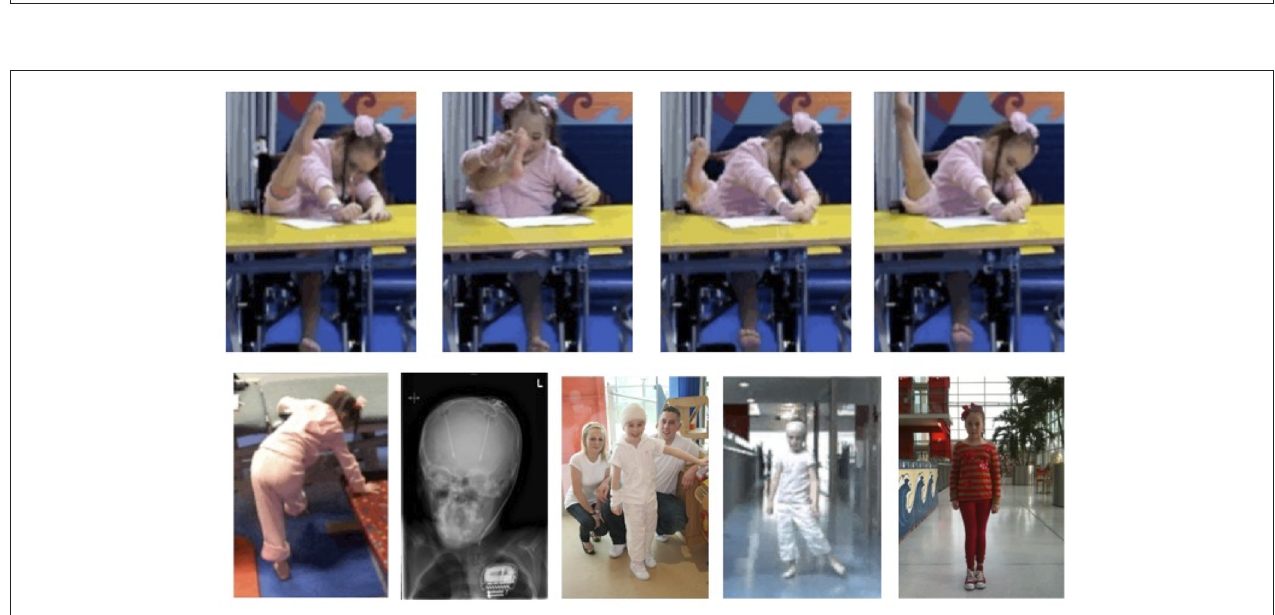
FIGURE 2 | DYT-1 dystonia and intrusive “ballerina postures” and improvements with Deep Brain Stimulation (DBS). Video frames over time before and after DBS. Onset age 6.0 years with rapid progression to wheel-chair mobility by age 6.5 years. (Top) “Ballerina posturing” of the right leg interferes with lying and sitting (see also Figure 1C ). [ Lower (left-right)]: unable to stand or walk; head and chest X-ray post ACTIVA RC rechargeable DBS implant, age 7 years; standing unsupported within days of DBS; walking unsupported 3 months post DBS with a left circumducting gait; fully recovered at 3 years post-DBS. Courtesy J-P Lin .